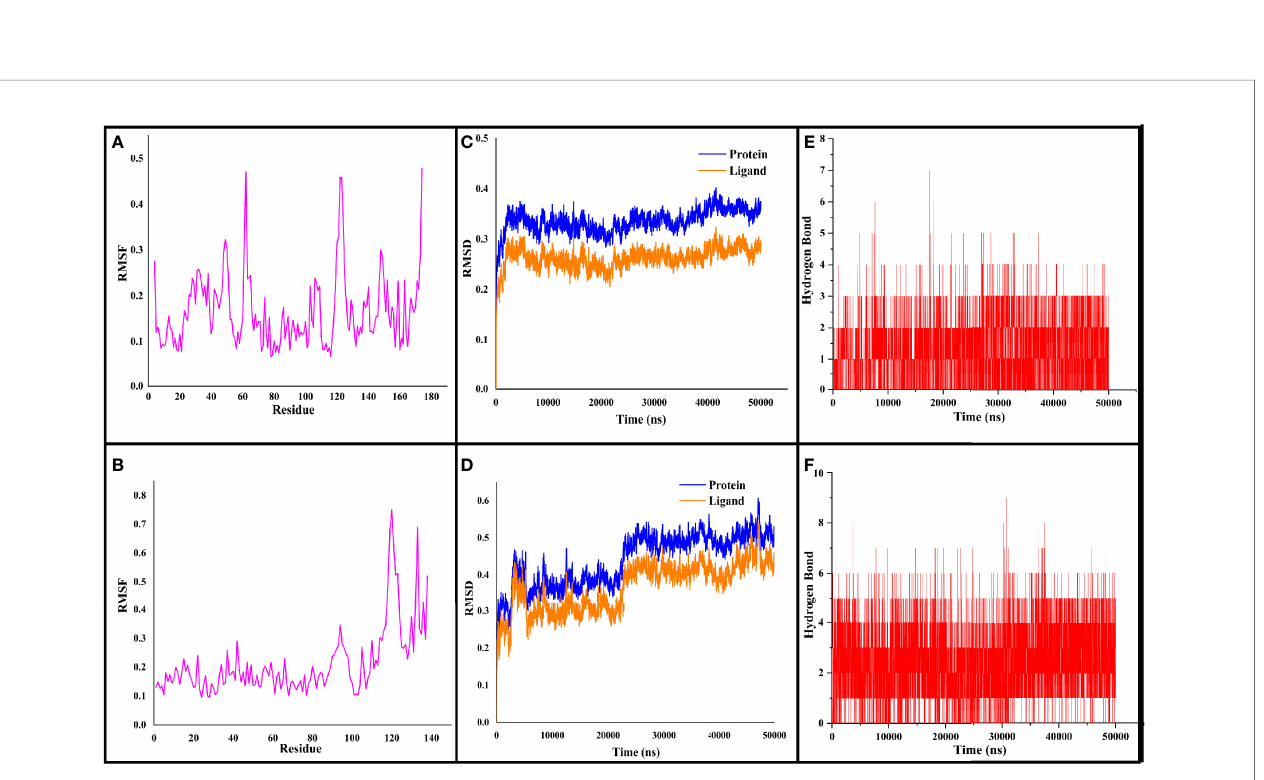
FIGURE 3 | The three-dimensional binding pattern of top hits QSSM 1157 (C) QSSM 1112 (D) and positive control farnesol (A, B) against CYCc and RAS1.